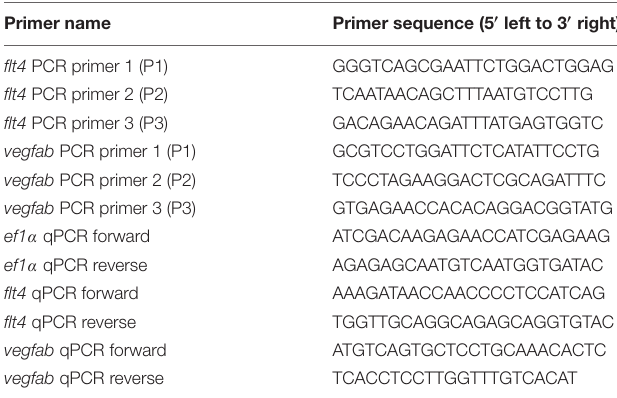
TABLE 2 | PCR and qPCR primers used to examine genomic deletions and mRNA expression. Primer